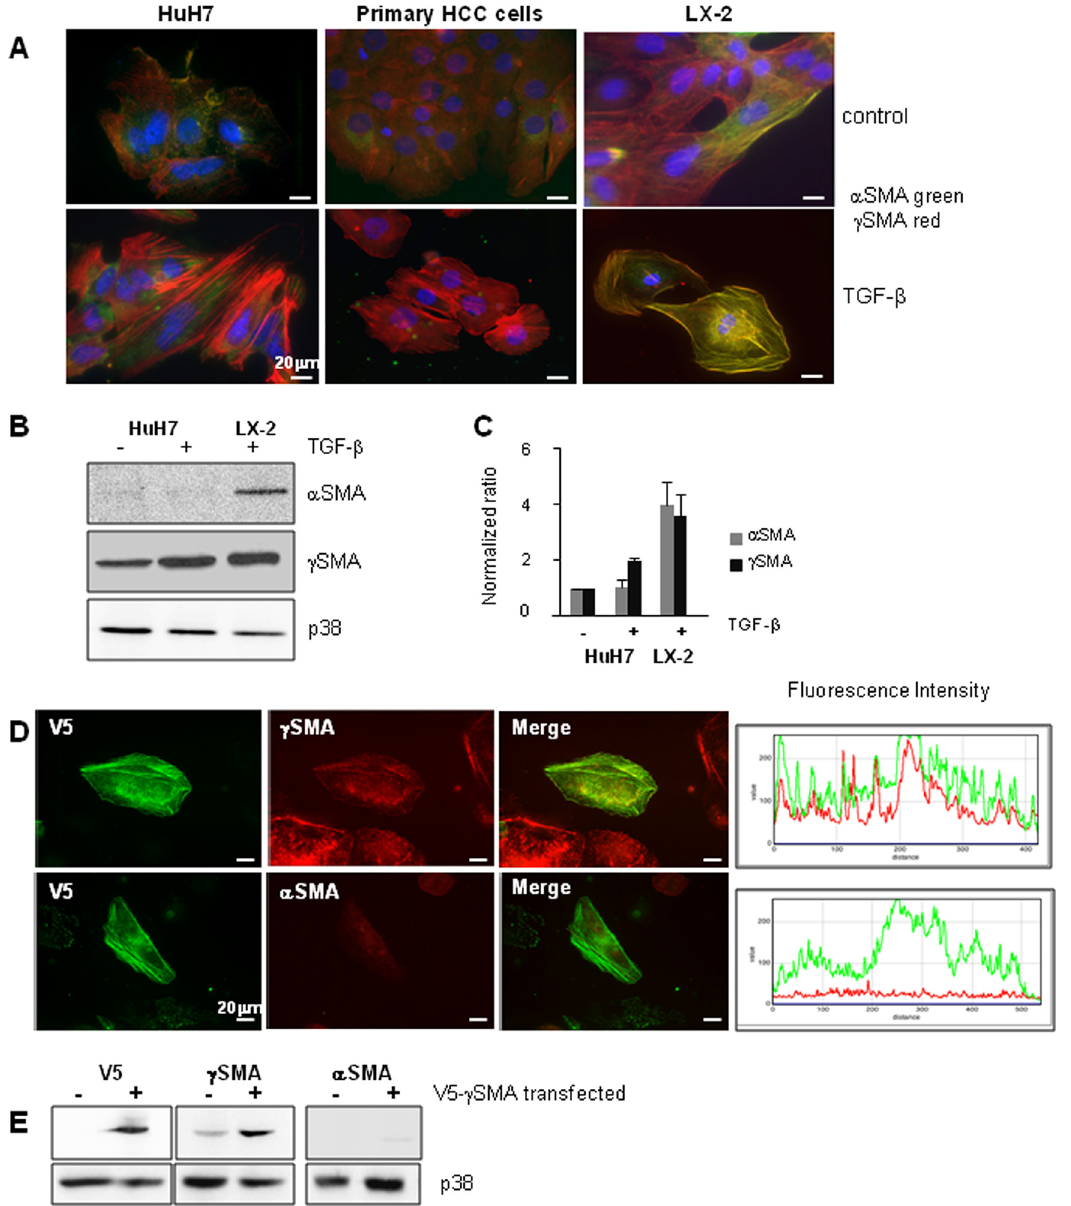
Fig 1. γ SMA is expressed in TGF- β -induced EMT. (A) HuH7 cells and primary HCC tumour cells were treated with TGF- β for 48h and the expression of γ SMA and α SMA was determined by immunofluorescence analysis. The images represent the merging of α SMA and γ SMA staining. LX-2 stellate cells activated by TGF- β for 48h were used as a positive control for α SMA expression; one out of three representative experiments is shown. (B) HuH7 cells were treated with TGF- β for 48h and cell extracts were analysed by Western Blotting for the expression of α SMA and γ SMA. TGF- β -treated LX-2 cells were used as positive controls for α SMA expression and p38 antibody was used as the control loading. (C) Densitometric analyses of the SMA/p38 ratio represent the mean +/- SD of three independent experiments. (D) HuH7 cells were transfected with a V5-tagged vector coding for γ SMA. Cells were treated with TGF- β for 48h, and the expression of V5, γ SMA and α SMA was determined by immunofluorescence analysis. Expression levels of V5 and γ SMA or V5 and α SMA were determined by measuring fluorescence intensity on a linear section of the cell. One representative experiment is shown. (E) HuH7 cells were transfected or not with a V5-tagged vector coding for γ SMA and cell extracts were analysed for the expression of V5, α SMA and γ